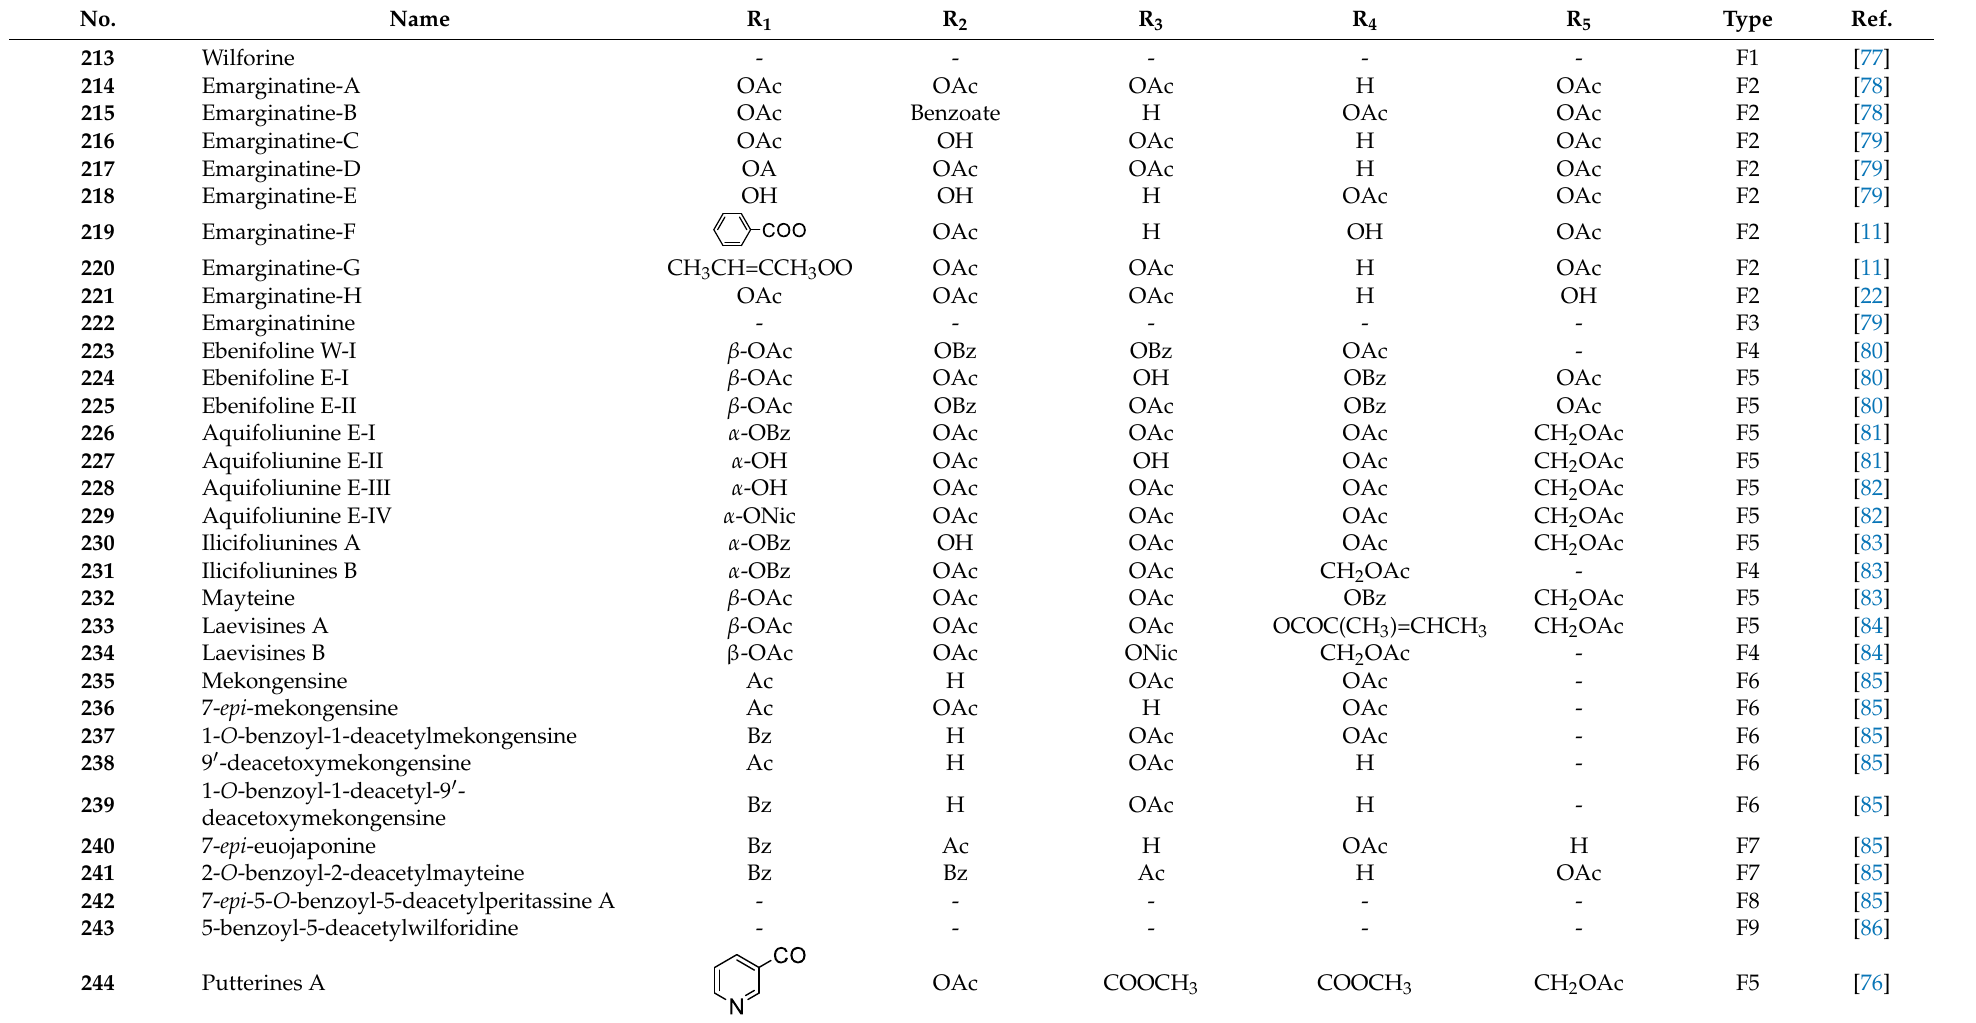
Table 6. The sesquiterpene pyridine alkaloids isolated from Maytenus .